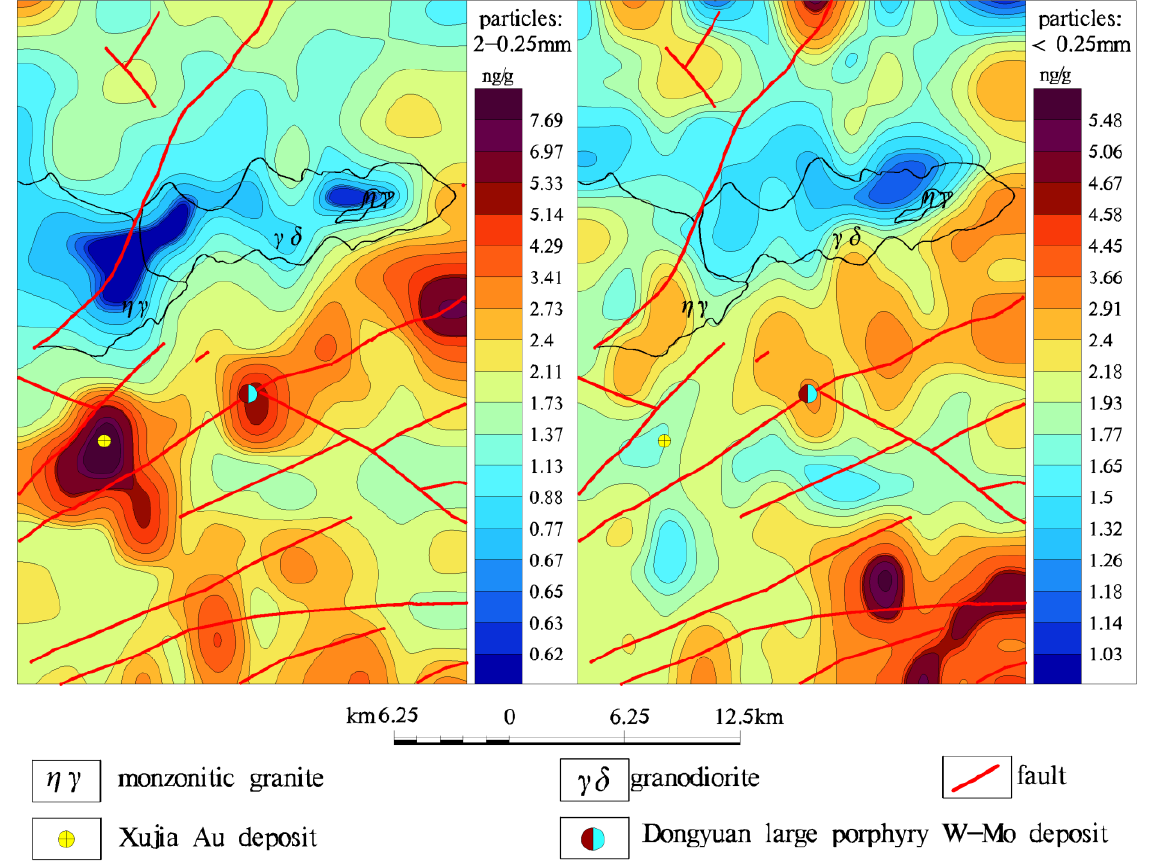
Figure 10. Geochemical maps of Au in 0.25–2 mm and <0.25 mm fraction of stream sediments in the pilot area.